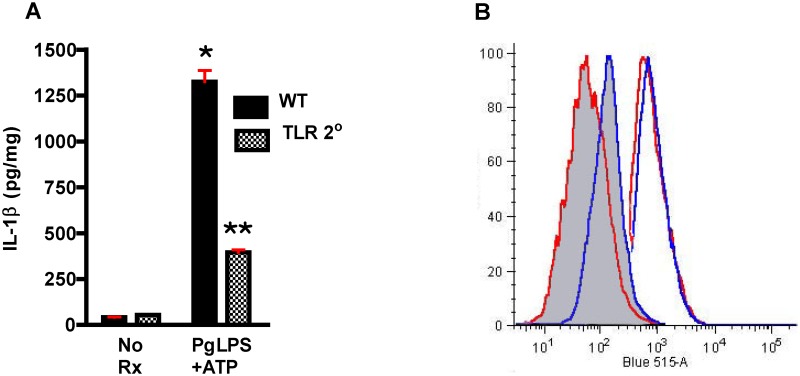
TLR2 plays a non-redundant role in IL1β generation in response to PgLPS.
A. PgLPS mediated IL1β generation is reduced in macrophages from Tlr2° mice compared with macrophages from WT mice. One way ANOVA, p< 0.0001. Bonferroni’s Multiple Comparison Test, *,**p<0.05. Experiment was performed in quadruplicate and repeated twice. B. Membrane expression levels of TLR2 are similar on macrophages from WT (red) and Cd36° (blue) mice by flow cytometry analysis. Isotype control antibody is shown in the shaded plots, anti-CD36/SR-B2 antibody by the unshaded plots. Experiment was performed in triplicate and repeated twice.